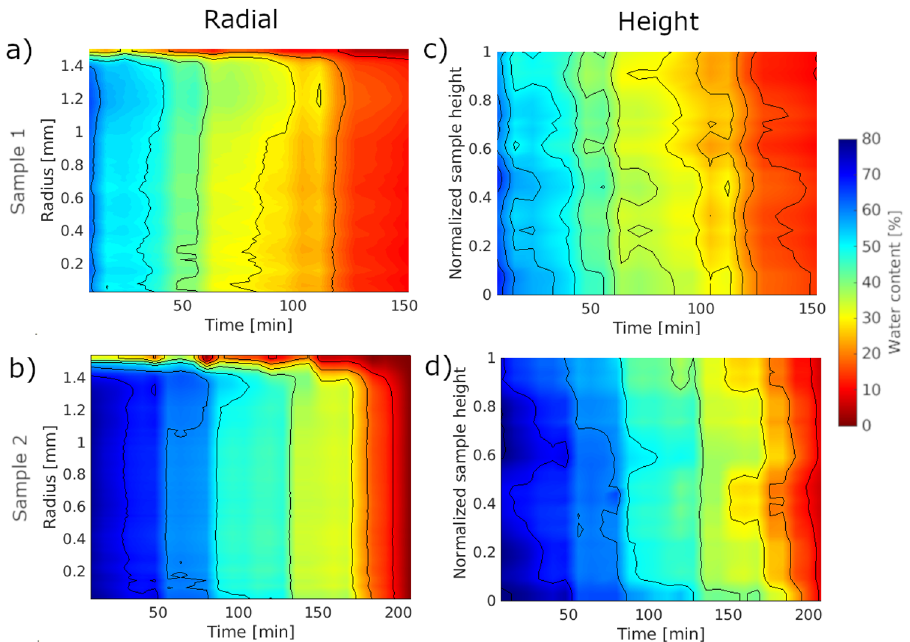
Figure 5. Radial (left column) and height (right column) distributions of water content in ( a ),( c ) sample 1, ( b ),( d ) sample 2 (created with MATLAB). For both samples, the water content is nearly equal over all radii except the outermost regions. This effect enhances over time until roughly 10% of water remains. Similarly, the water content is uniform over the whole height of the sample with slightly more water at the